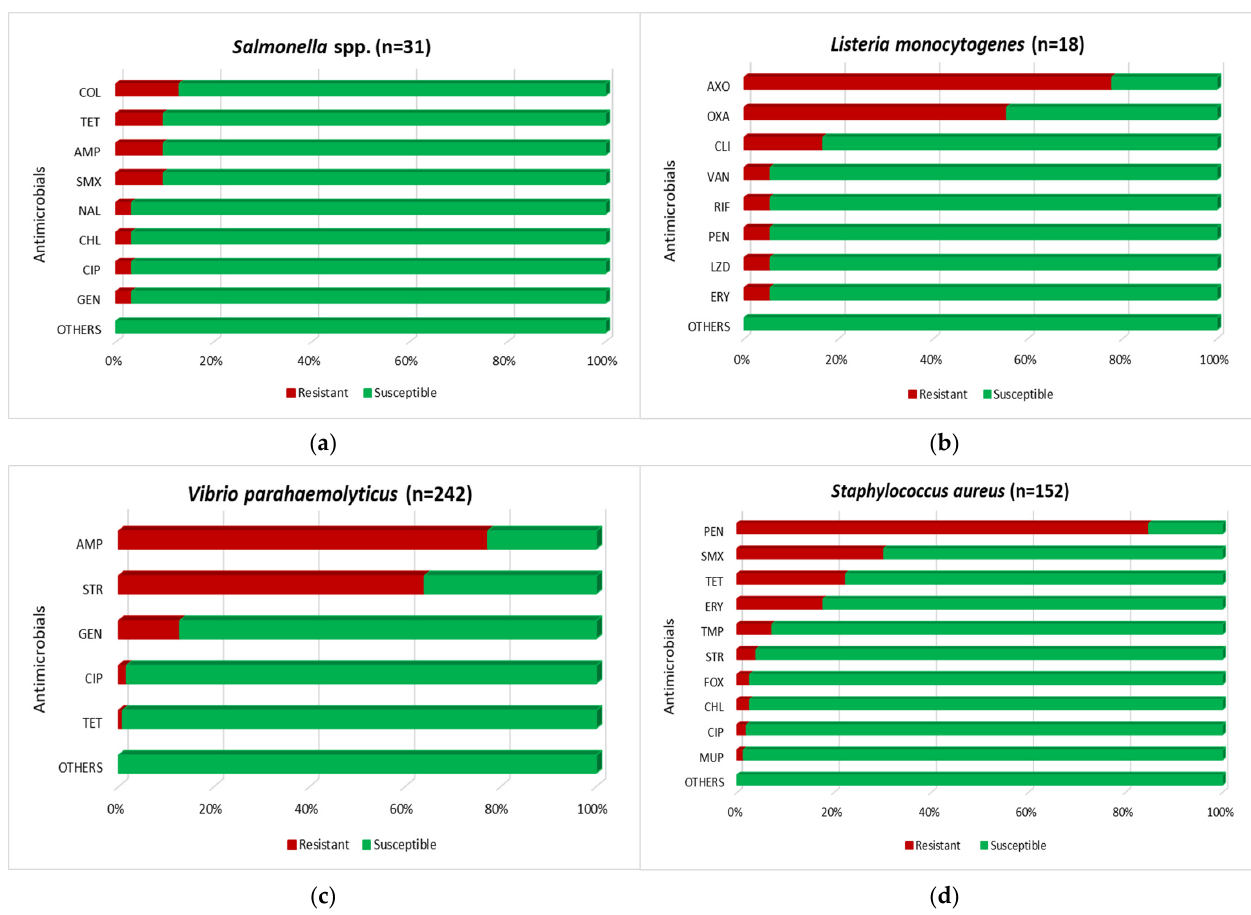
Figure 1. The prevalence (%) of resistance to antimicrobials in tested isolates: ( a ) Salmonella spp., ( b ) L. monocytogenes , ( c ) V. parahaemolyticus , and ( d ) S. aureus . COL, colistin; TET, tetracycline; AMP, ampicillin; SMX, sulfamethoxazole; NAL, nalidixic acid; CHL, chloramphenicol; CIP, ciprofloxacin; GEN, gentamicin; AXO, ceftriaxone; OXA, oxacillin; CLI, clindamycin; VAN, vancomycin; RIF, rifampicin; PEN, penicillin; LZD, linezolid; ERY, erythromycin; STR, streptomycin; TMP, trimethoprim; FOX, cefoxitin; MUP, mupirocin.